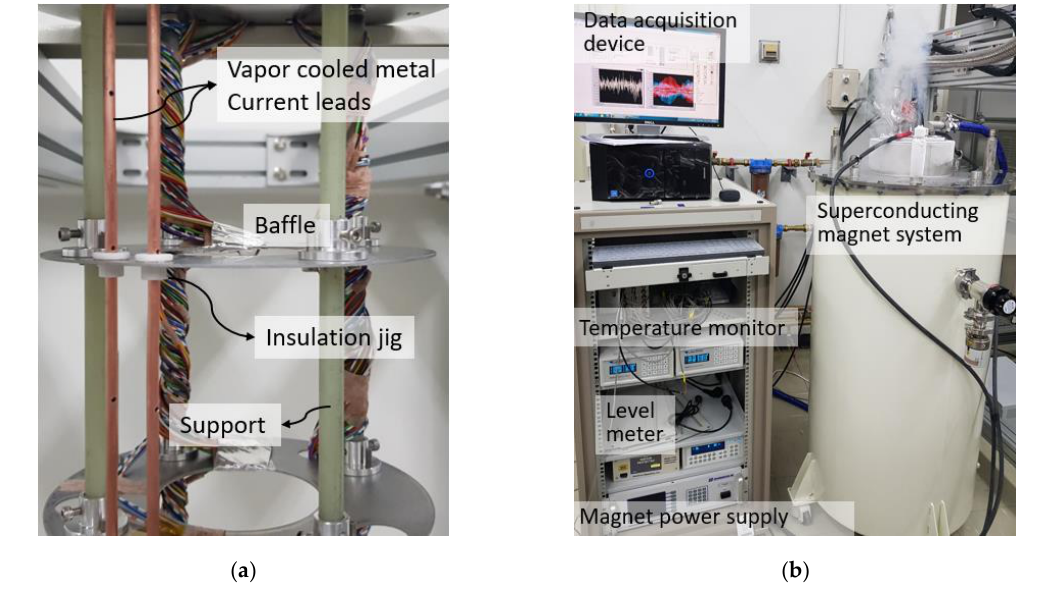
Figure 8. Experimental setup of the 5 T superconducting magnet system. ( a ) Installation of the vapor-cooled current leads; ( b ) Entire experimental setup including the data acquisition system.